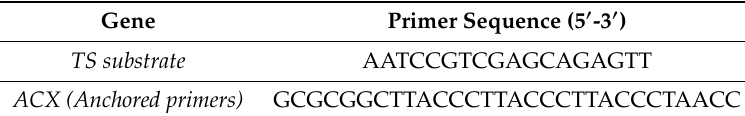
Table 5. Primer used in telomerase activity assessment.